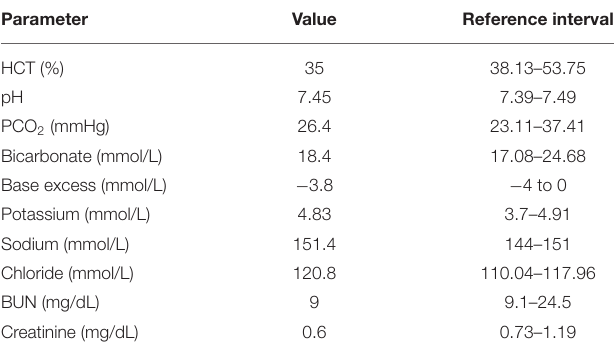
TABLE 1 | Venous blood gas findings on presentation to the emergency room.